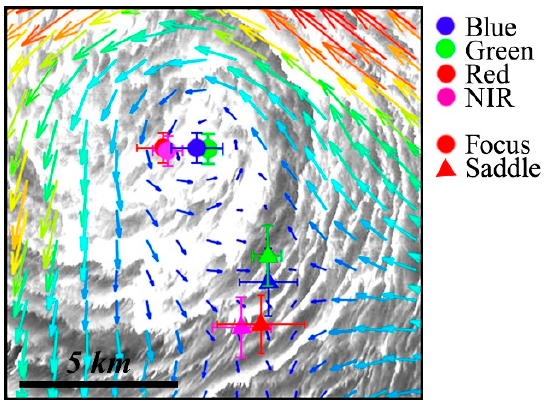
Figure 7. Positions of the points of zero velocity in different bands.